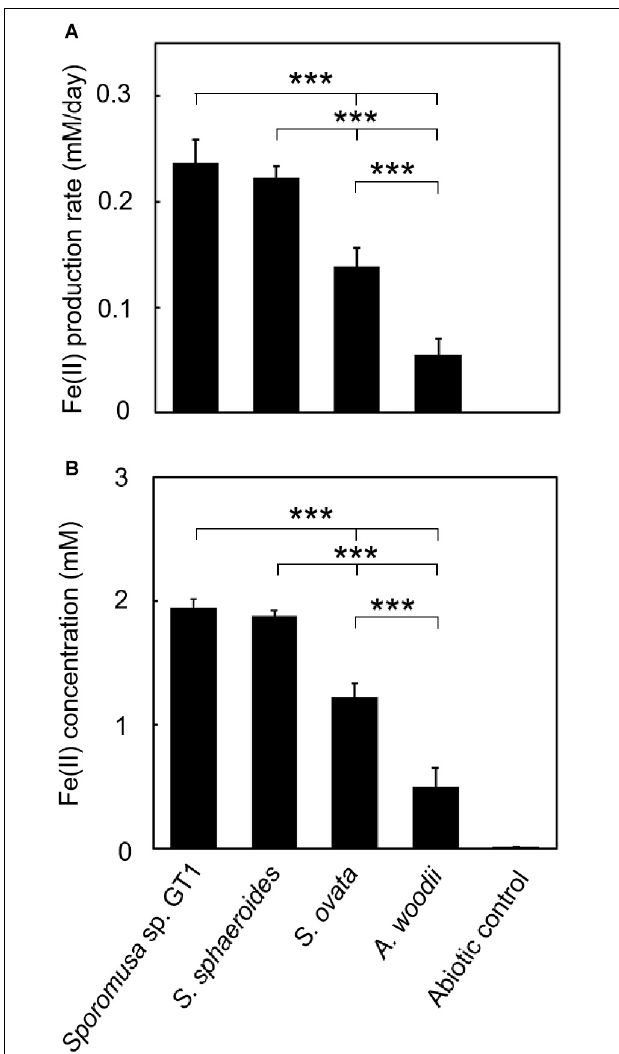
FIGURE 6 | Difference in crystalline Fe(III) oxide reduction activity among homoacetogens under organotrophic growth conditions. Homoacetogens were cultivated on ethanol (20 mM) in the presence of goethite [ α -FeO(OH), 9 mmol/L] or hematite ( α -Fe 2 O 3 , 4.5 mmol/L). The white and black bars indicate Fe(II) contents in the supernatant and sediment, respectively. Data are presented as the means of three independent cultures, and error bars represent standard